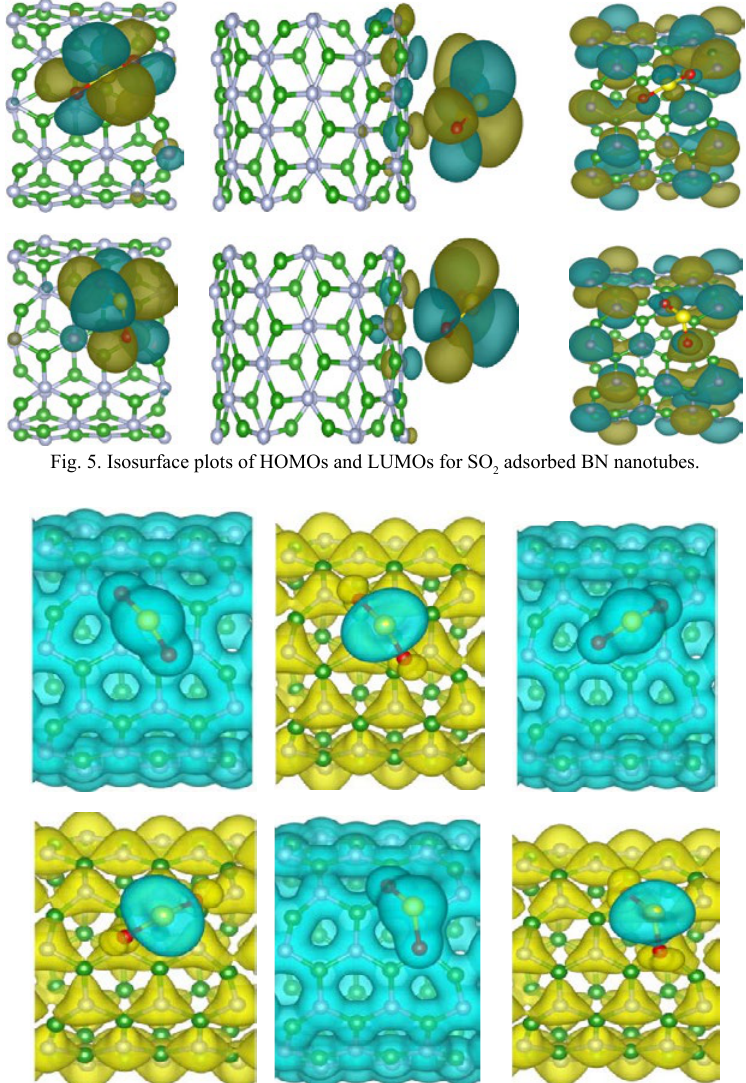
Fig. 6. Calculated Kohn-Sham and Hartree-Fock potential Isosurfaces for SO Figure 6. Calculated Kohn-Sham and Hartree-Fock potential Isosurfaces for SO 2 adsorbed BN nanotubes.